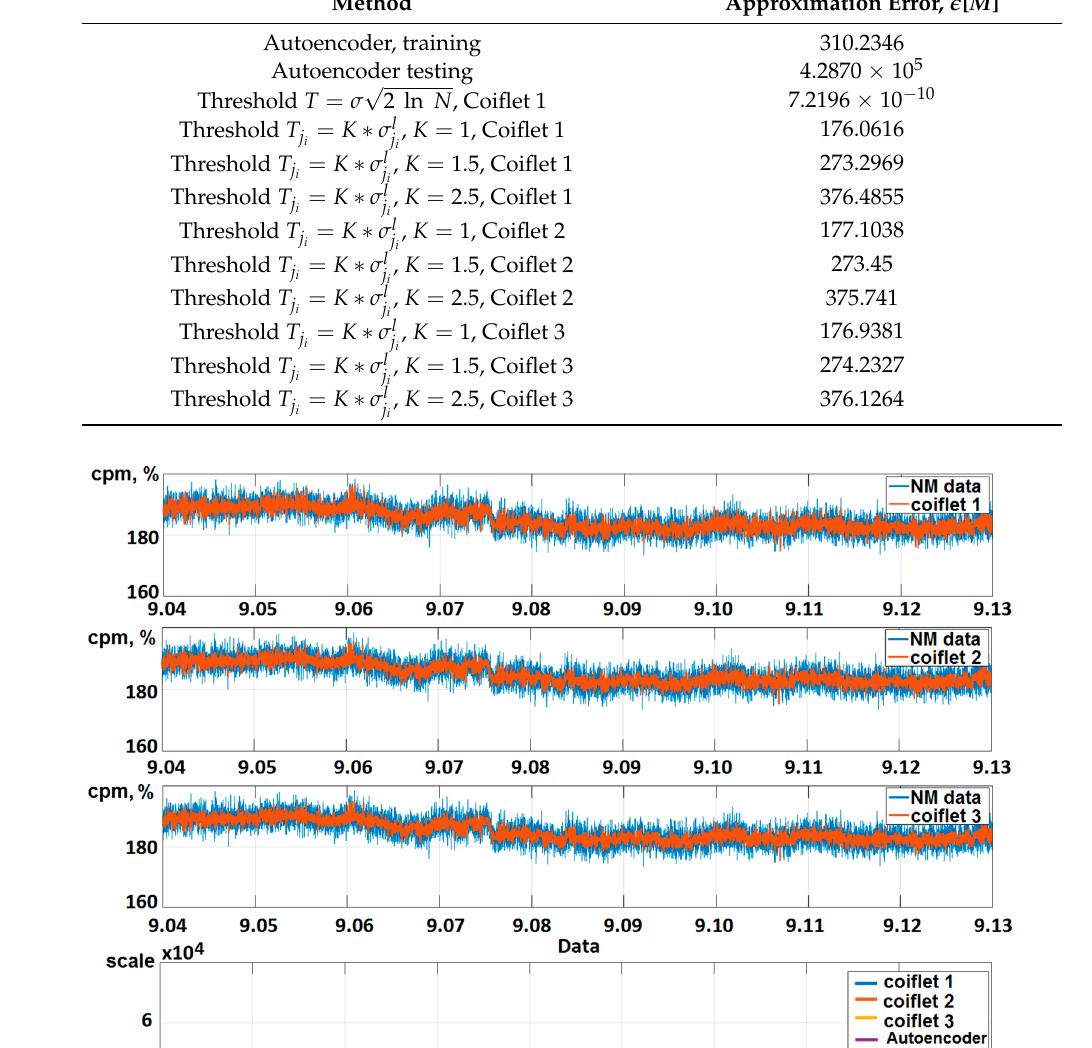
( a ) ( b ) Figure 9. NM data processing results (2014.03.25): ( a ) the proposed method, the threshold used was 𝑇 (cid:3037) (cid:3284) = 2,5 ∗ 𝜎 (cid:3037) (cid:3284) (cid:3039) ; ( b ) autoencoder.